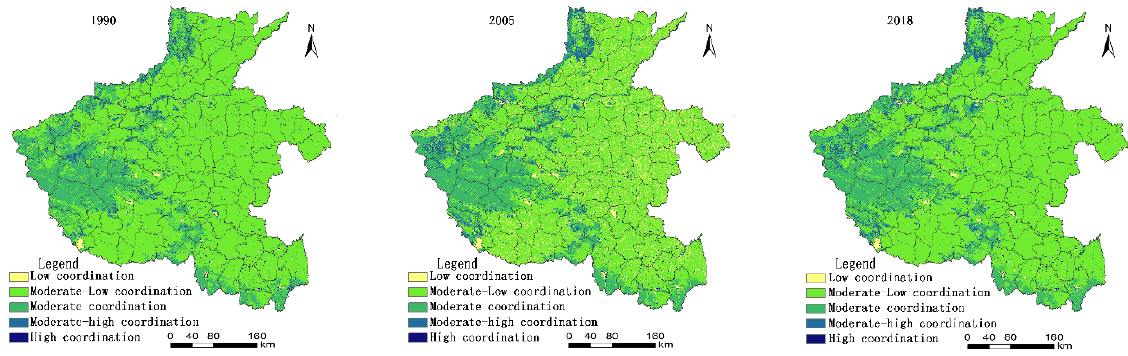
Int. J. Environ. Res. Public Health 2021 , 18 , x FOR PEER REVIEW Figure 5. Evaluation results of coordination function of territory space in Henan Province from 1990 to 2018.